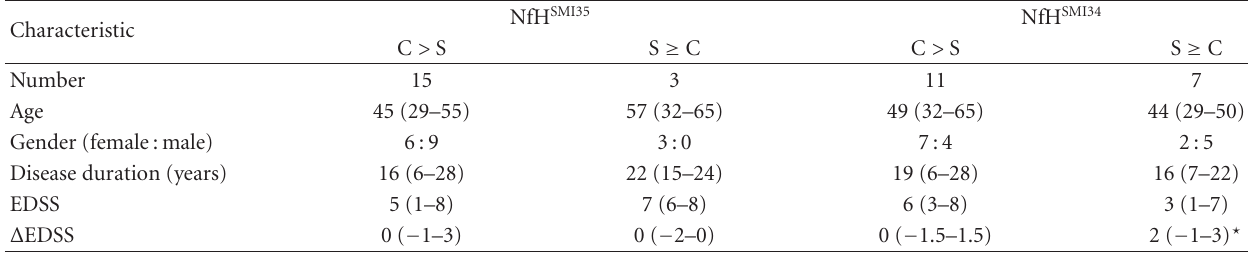
Table 4: Secondary progressive MS. The patients were classified according to the relationship of CSF and blood NfH levels. If the concentration was higher in the CSF compared to the blood, this was indicated by “C > S” and “S ≥ C” otherwise. The data is presented for each of the two NfH phosphoforms quantified (NfH SMI34 and NfH SMI35 ). (cid:2) P < . 05 .